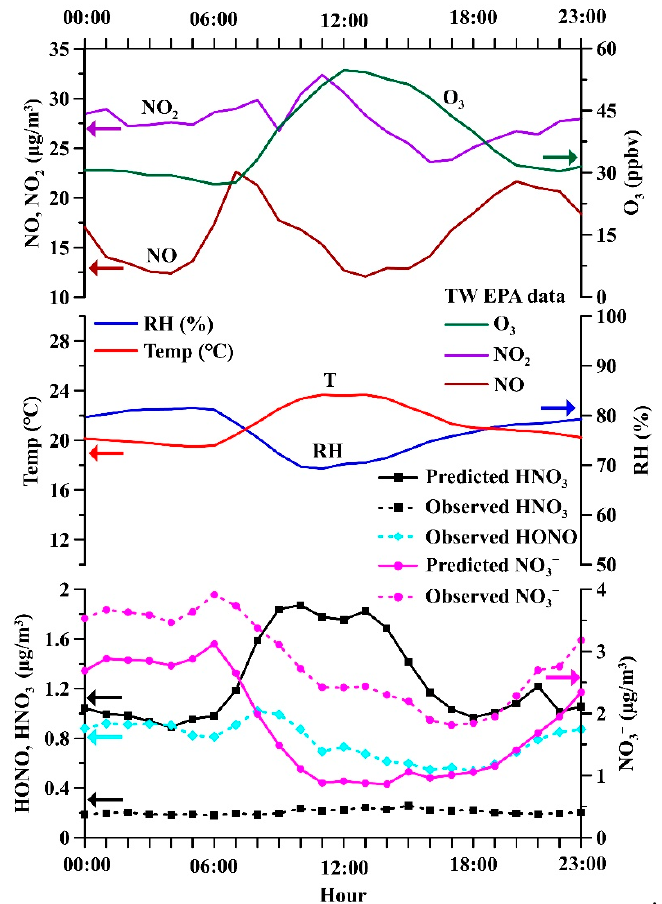
Figure 9. Average data of each hour of the predicted/observed HNO 3 , the observed HONO, the predicted/observed NO 3 − , the temperature, the relative humidity, NO 2 , NO, and O 3 .